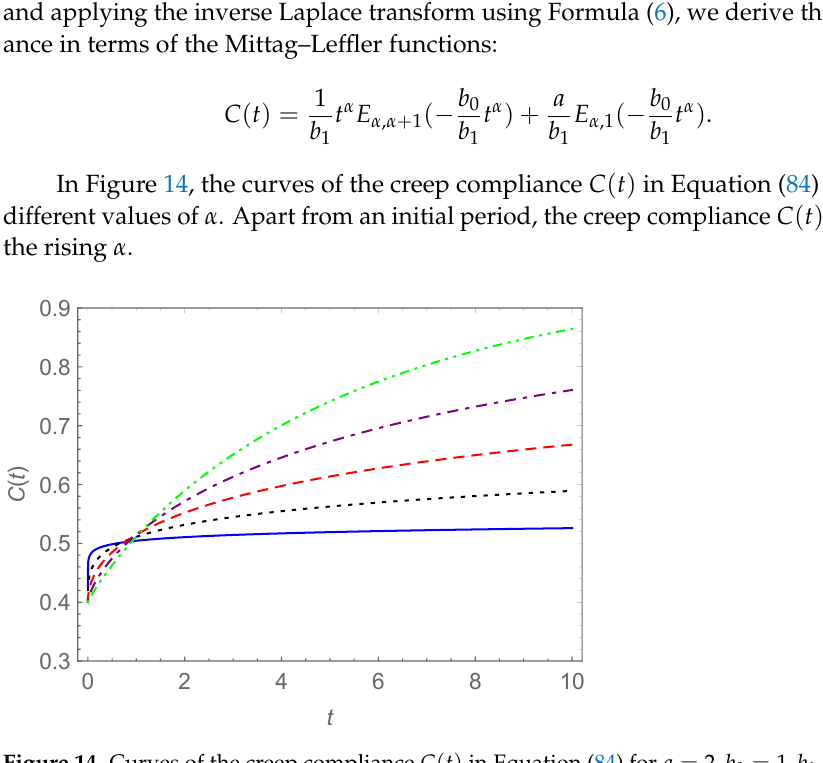
Figure 14. Curves of the creep compliance C ( t ) in Equation (84) for a = 2, b 0 = 1, b 1 = 5, and α = 0.1 (solid line), 0.3 (dotted line), 0.5 (dashed line), 0.7 (dotted–dashed line), and 0.9 (dotted–dotted– dashed